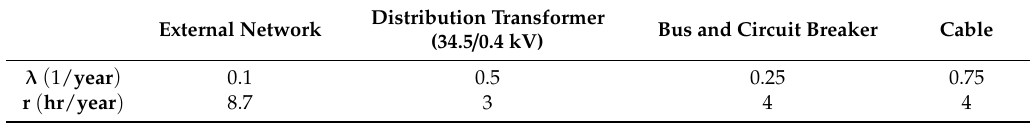
Figure 3. Daily load curve of the distribution feeder for winter. Table 1. Failure rate and mean time to repair parameters of distribution feeder